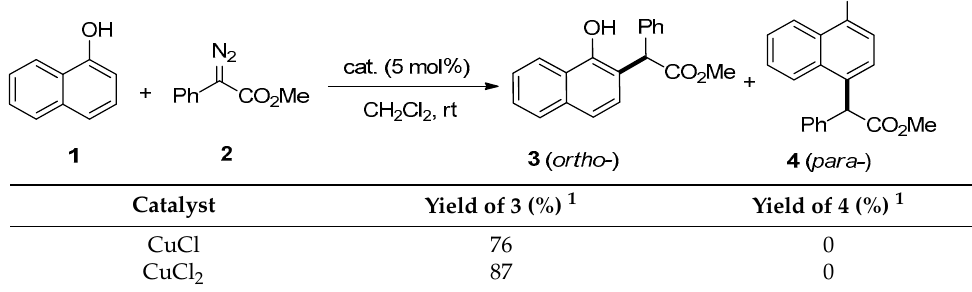
Table 1. Copper-catalyzed C(sp 2 )-H bond functionalization of naphthols with α -diazoesters [63].